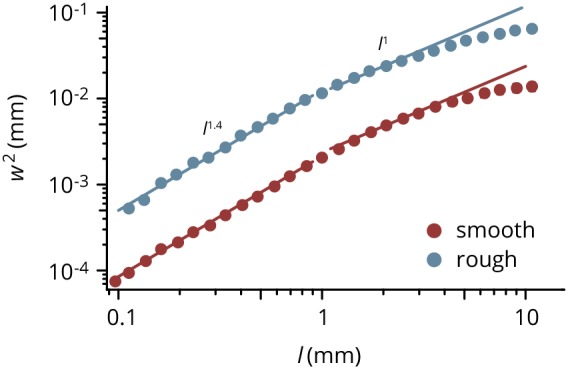
Roughness of E.coli colonies on smooth and rough substrates, defined as the mean square deviation from the best-fit circle.Colony boundaries were extracted and the variance w2 of the radius fluctuations measured over different window lengths l. For interfaces in the KPZ universality class, w2∼l. Points are averages over 118 (smooth) and 193 (rough) colonies, error bars are smaller than the symbols.10.7554/eLife.44359.009Figure 1—figure supplement 3—source data 1.Source data for Figure 1—figure supplement 3 (Roughness of smooth and rough colonies).